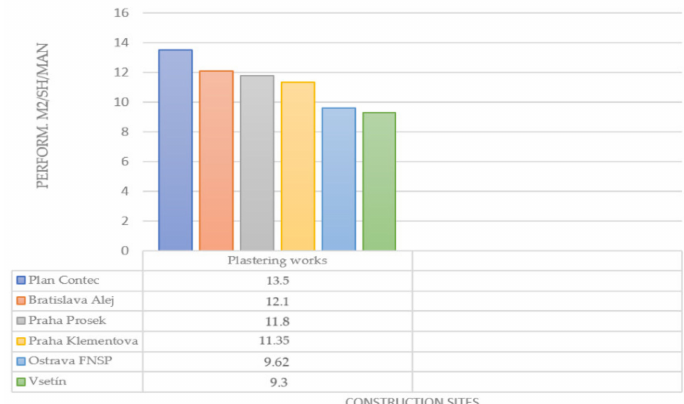
Figure 19. Comparison of masonry works productivity.